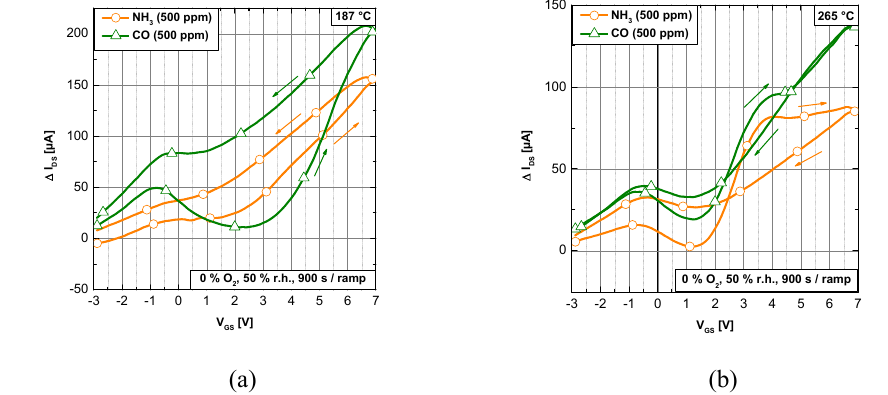
Figure 7. Hysteresis of ∆ I DS for CO (green, triangles) and NH 3 (orange, circles) in pure nitrogen at 50% RH at 187 ◦ C (a) and 265 ◦ C (b) .